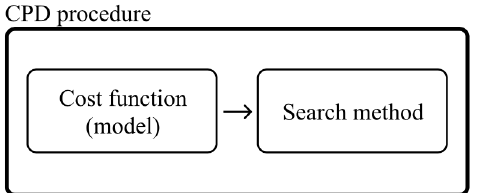
Figure 1. Components of a typical non-ensemble changepoint detection (CPD)